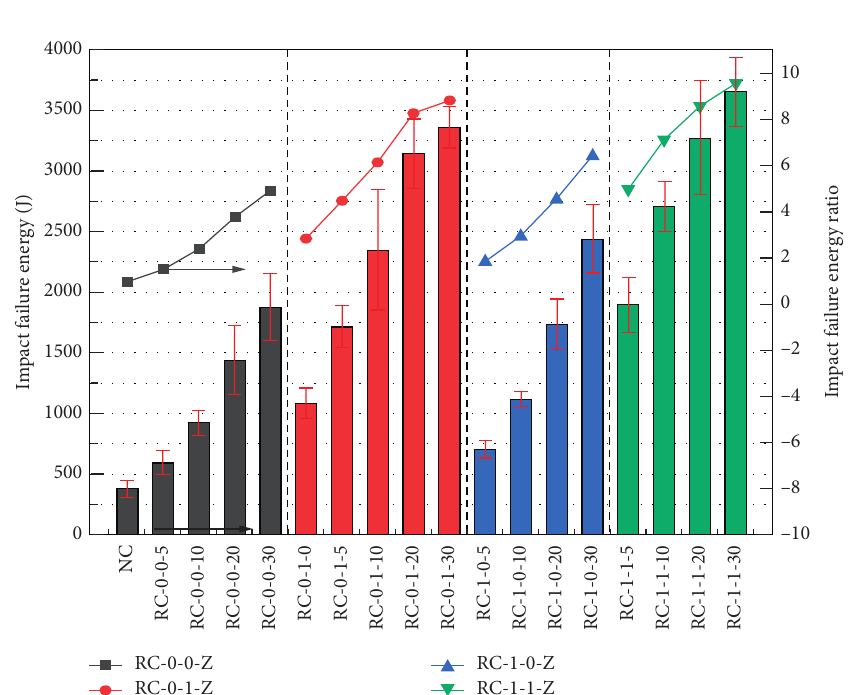
Figure 12: Water absorption rate.